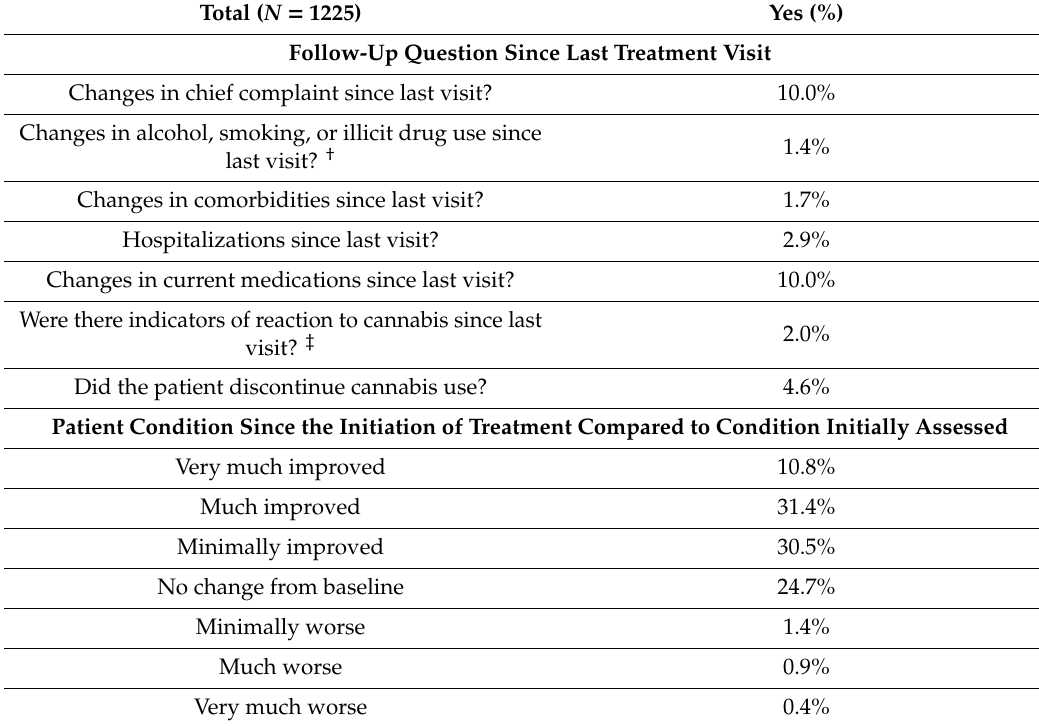
Table 4. Summary of the follow-up information reported by Florida medical marijuana registry patients at a follow-up visit after treatment initiation for total follow-up